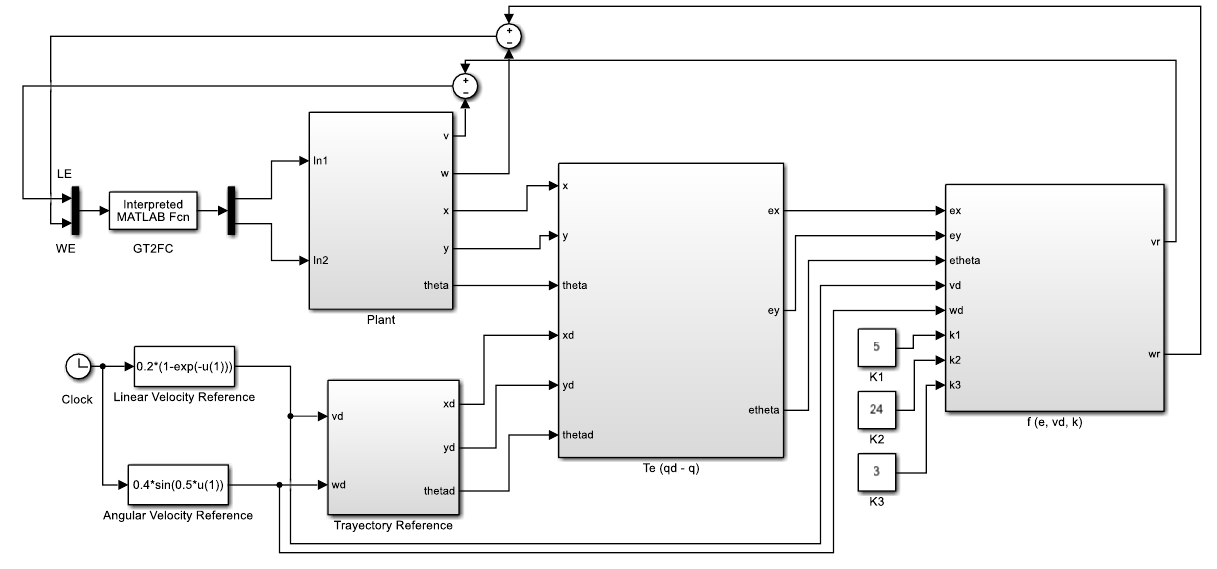
Figure 8. GT2FC of the mobile robot. The GT2FDE method was used to test the efficiency of the general type 2 fuzzy controller. The configuration of the GT2FDE algorithm parameters used in the experimentation are as follows: CR parameter at 0.5, population of 45, number of simulations is 30, 100 generations. To test the performance index of the GT2FC controller, simulations were performed without disturbances and with disturbances in the controller. The following Table 3 indi- cates the types of disturbances and the configurations of the used